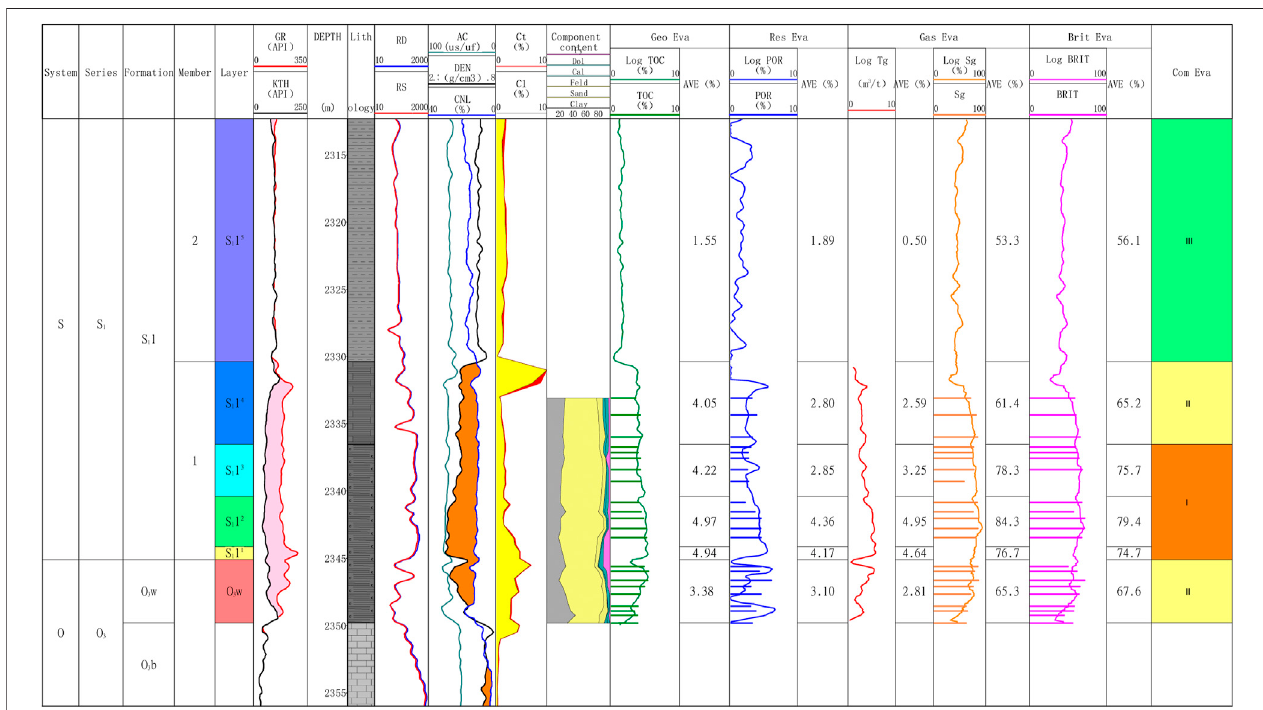
FIGURE 3 | Comprehensive column of well Anye A drilled through the Ordovician Wufeng Formation and Silurian Longmaxi Formation.